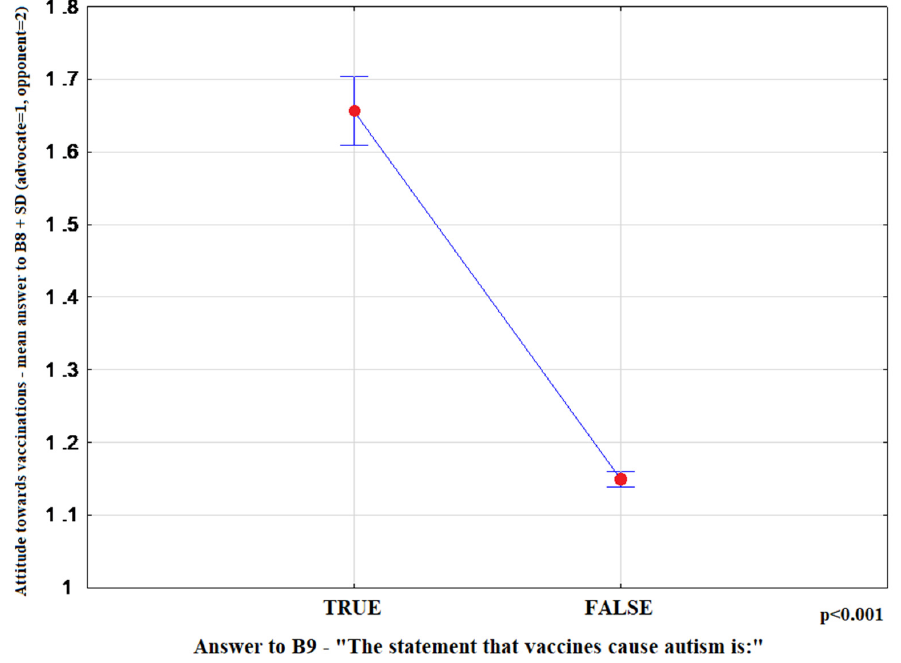
Figure 5. Mean rank-answer to the question about the attitude toward vaccination (B8) + SD depending on the opinion about the relationship between vaccines and autism (B9). Answers to B9: TRUE n = 299; FALSE n =